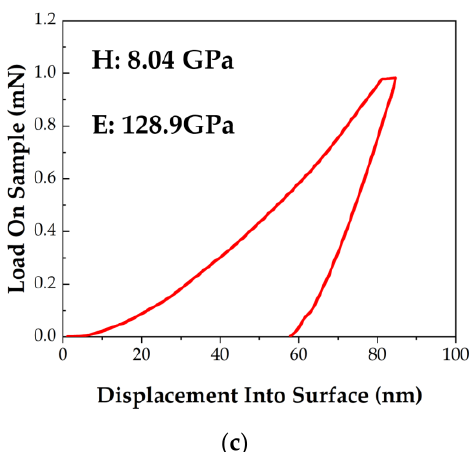
Figure 5. ( a ) The 3D AFM image of the as-deposited thin film. ( b ) The height difference profile between the substrate and the thin film. ( c ) The load-displacement curve of the thin film.